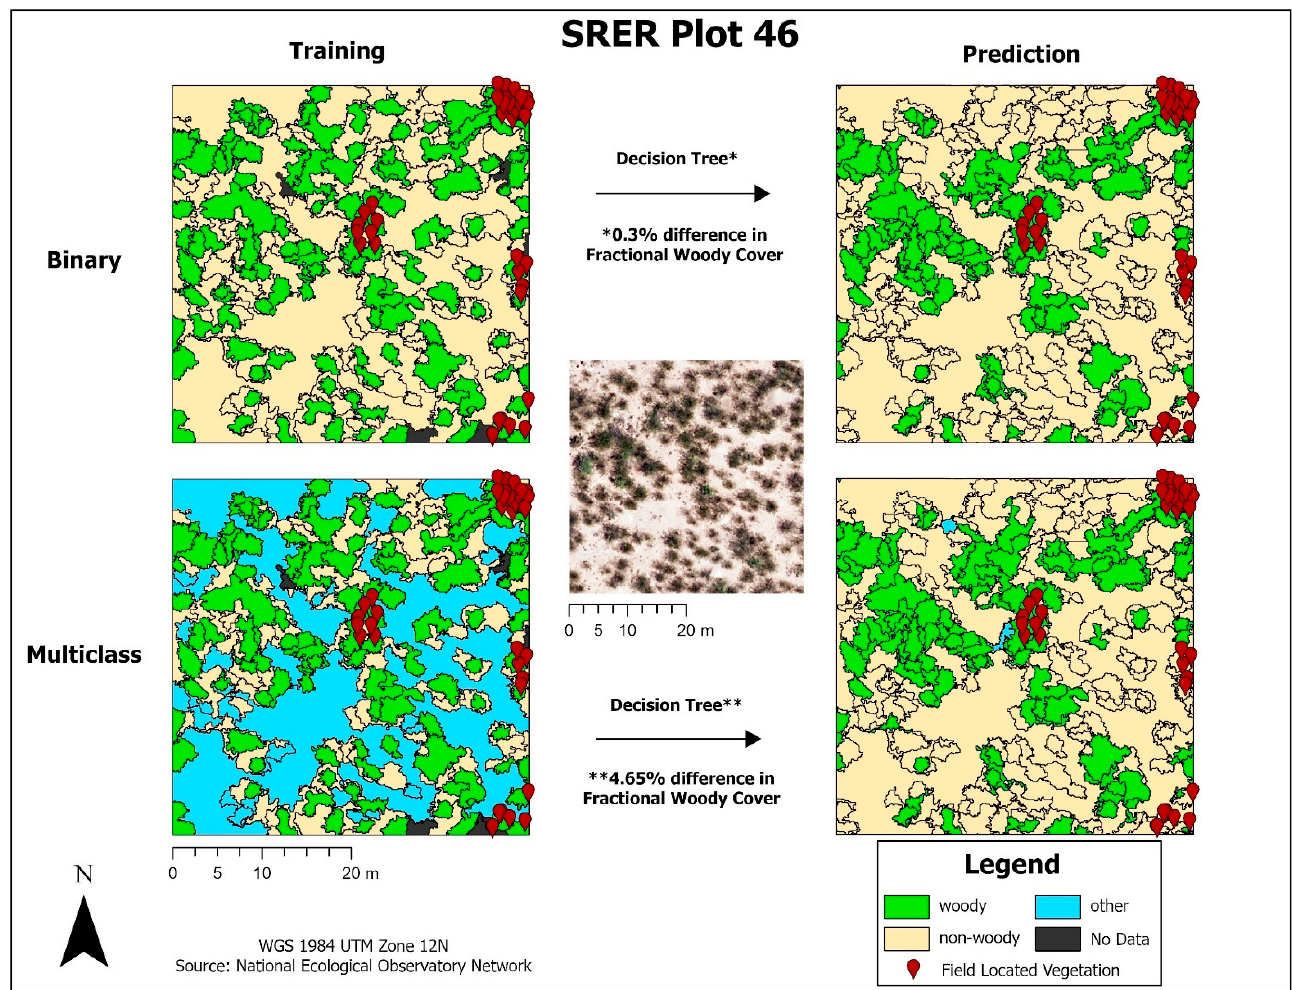
Figure 8. Decision Tree predictions for Plot 46 for the binary and multiclass schemes. Despite having the worst performance overall, the Decision Tree model performs very well at this moderate FWC plot under the binary classification scheme, although the areas of less-green live vegetation to the east and southeast are still misclassified. Decision Tree also differed from eXtreme Gradient Boost for the multiclass prediction in that it did not predict much “other” cover, which is consistent with the Decision Tree predictions for Plot 14. Decision Tree overpredicted FWC in the multiclass scheme with a relatively high dFWC value of 4.65%. Like the previous models, woody vegetation was predicted in a more clustered pattern than in the training data.